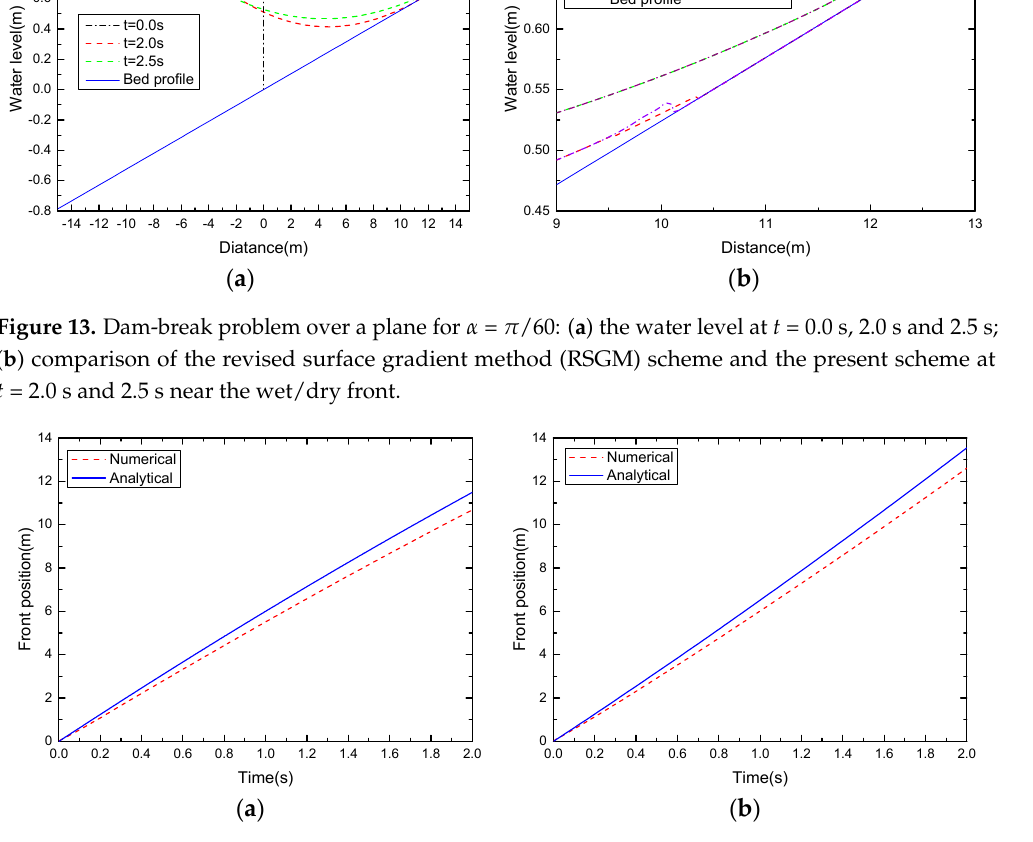
Figure 14. Dam-break problem over a plane. Time evolution of wet/dry position: ( a ) α = π /60; ( b ) α = − π /60.